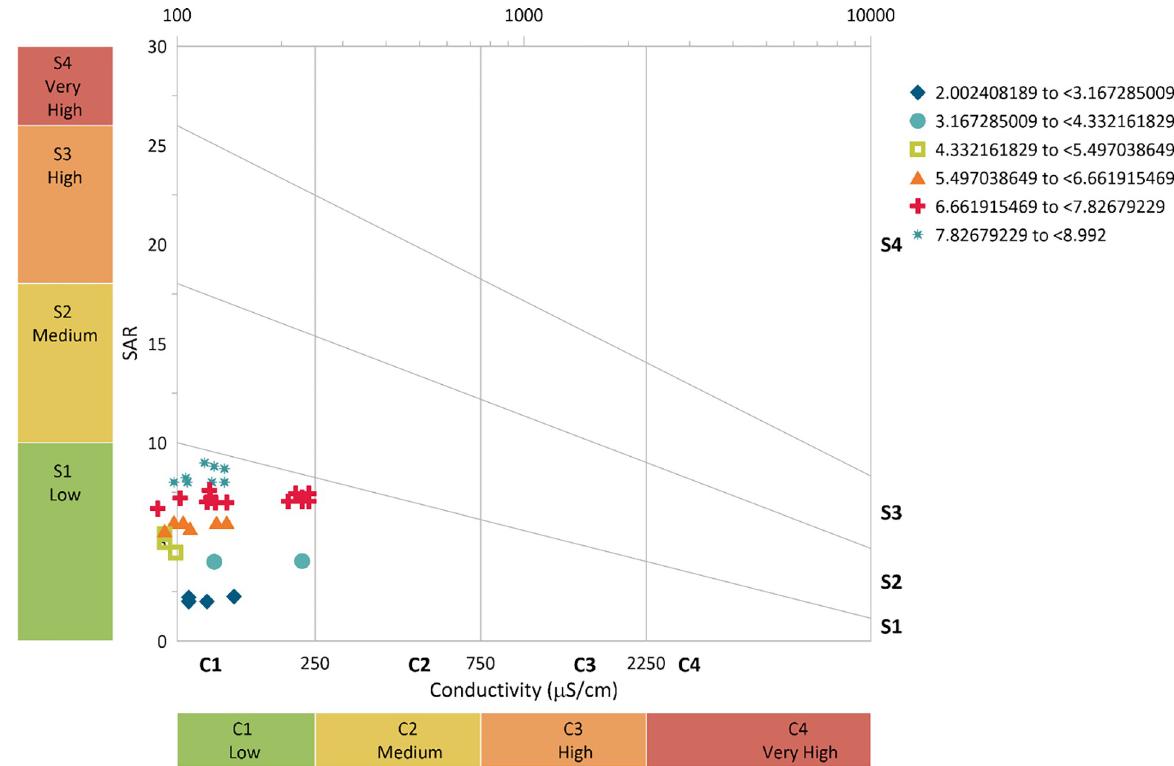
Fig 11. Salinity hazard from 1 m column